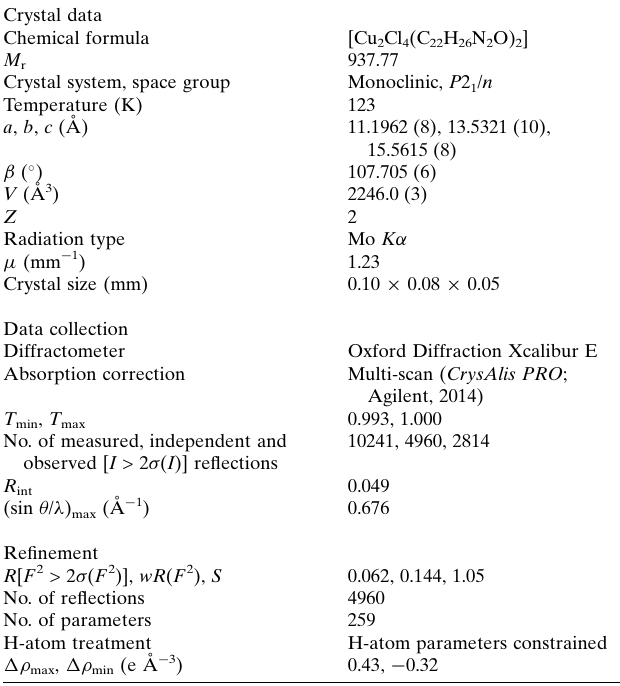
Table 2 Experimental details. Crystal data Chemical formula